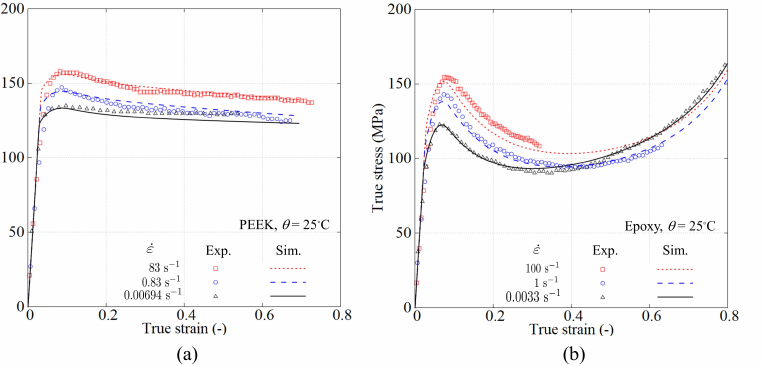
Figure 11. Comparison of the stress–strain curves between the model and the test at different strain rates: ( a ) PEEK KT880 − NT and ( b )